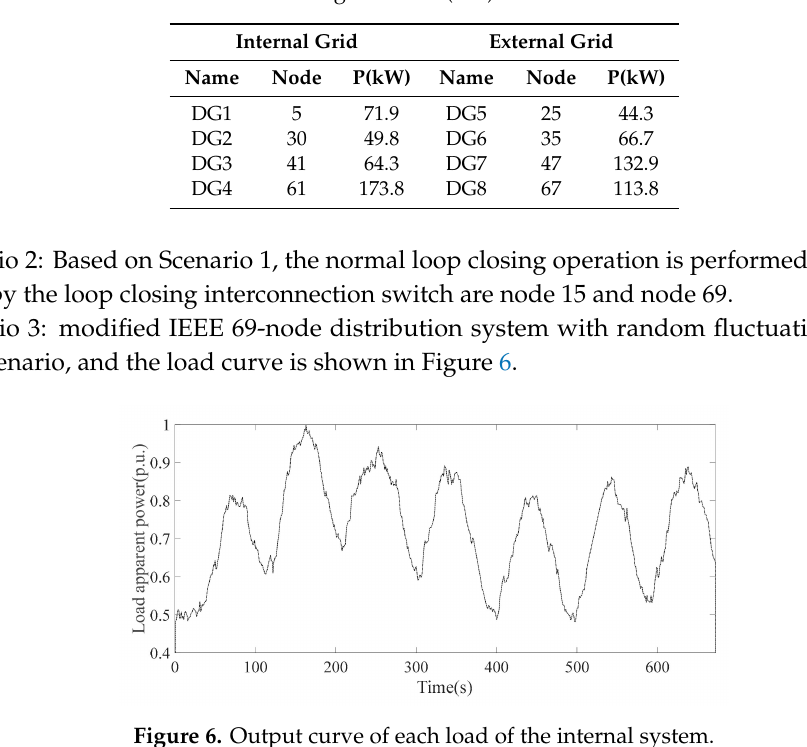
Table 1. Distributed generation (DG) information in Case 1.